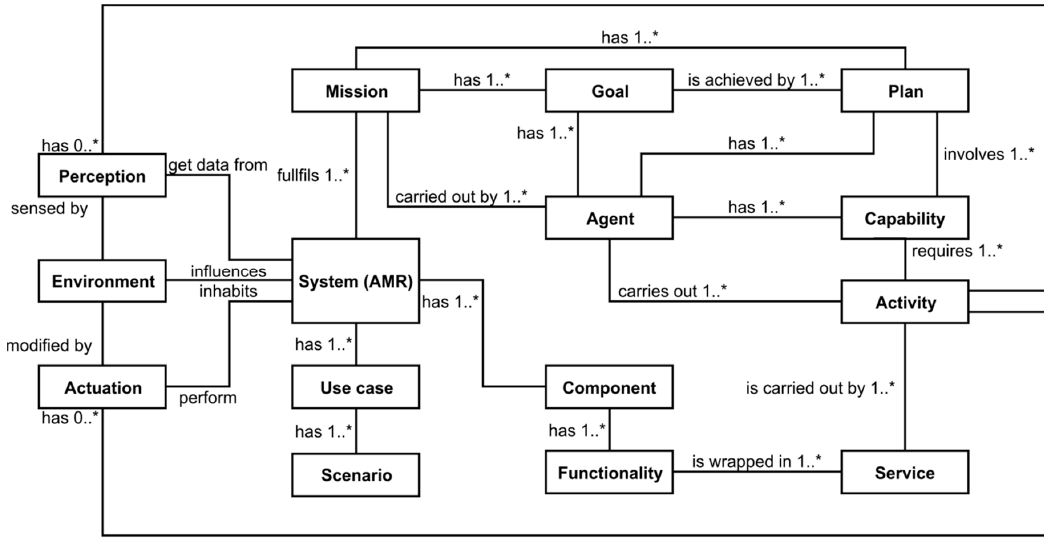
Figure 14. ICA ontology.